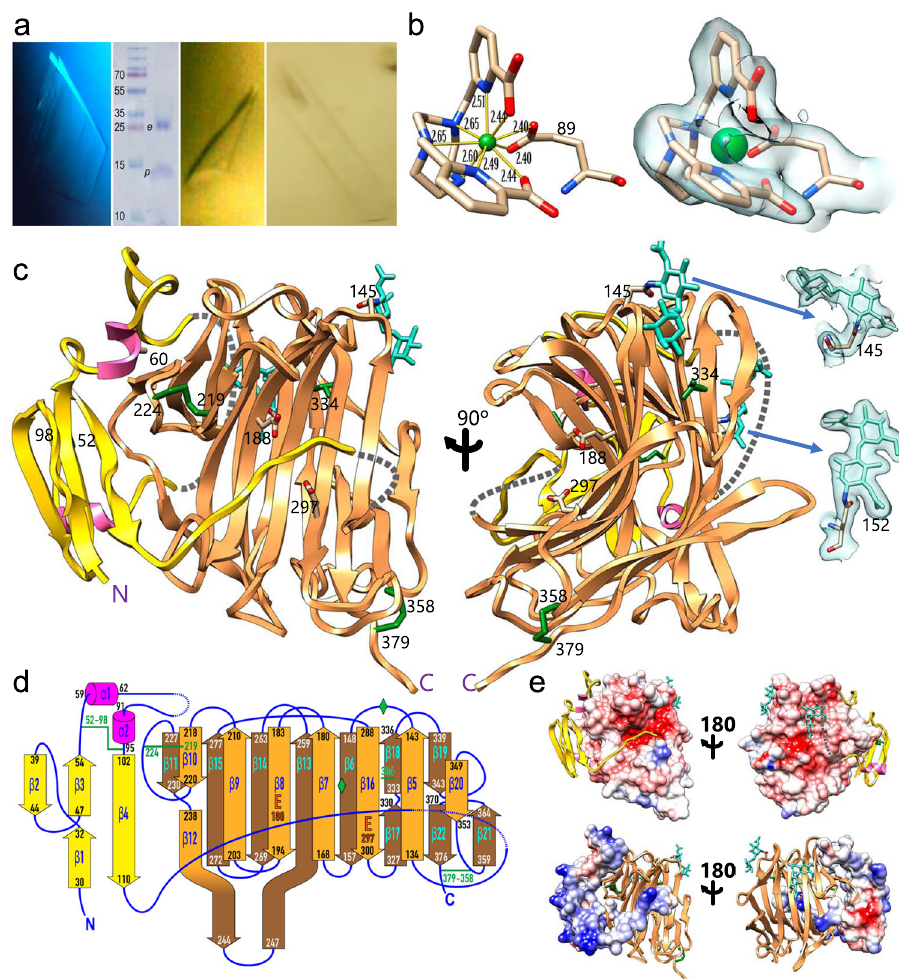
Fig. 5| Structuresofpro-neprosinand neprosin. a Orthorhombiccrystalsof pro- neprosin (left panel) contained a complex of the cleaved PD ( p ) and the CD ( e ) (centre-left panel). Mature enzyme crystals were monoclinic (centre-right panel, crystal form I; right panel, crystal form II). The experiment of the centre-left panel was performed once. b The structure of pro-neprosin was solved using a lutetium derivative. At one site (left panel), the Lu 3+ cation (green sphere) was nona- coordinated by two carboxylate oxygens plus fi ve nitrogen atoms from the organic scaffold and the carboxylate oxygens of protein residue E 89 at distances spanning 2.40 – 2.65Å. Final (2m F obs - DF calc )-type Fourier map of the derivative contoured at 1.3 σ (right panel). c Ribbon-type plot of pro-neprosin in frontal (left panel) and lateral (right panel) perspectives. The PD is gold with magenta helices. The mature enzyme is shown in salmon. Disordered/cleaved segments are indicated by grey dashedlines.ThetwoglycosylationsitesatN 145 andN 152 ,thesevencysteines,A 60 ,and